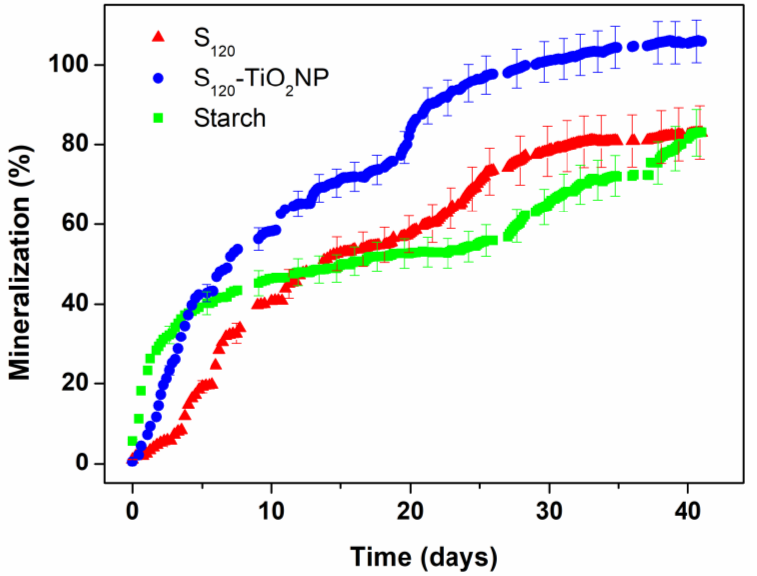
Figure 8. Percentage mineralization as a function of time for S 120 , S 120 -TiO 2 NP and starch in the DMR system. Mineralization error bars for the replicates are represented at selective times to facilitate the reading of the plots.